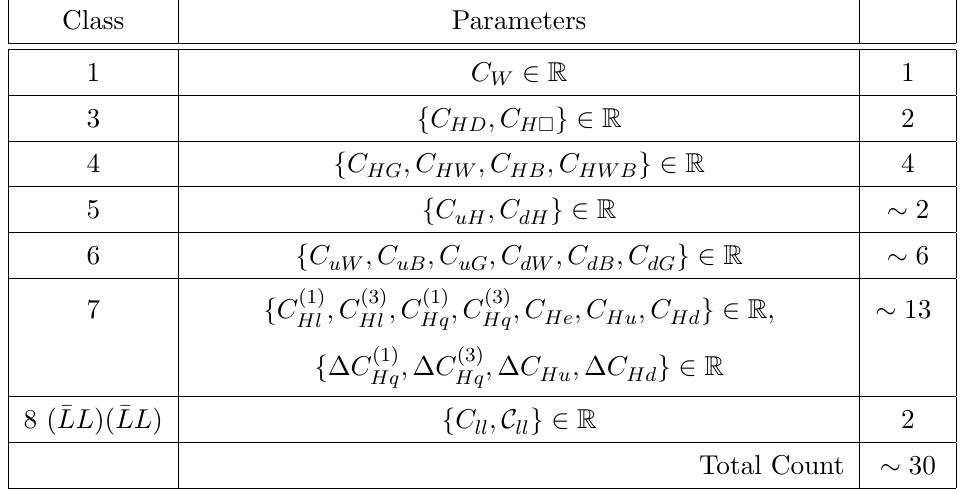
Table 7 . Parameter counts in the MFV SMEFT for a ‘WHZ pole parameter’ program. The parameter counts that are approximate rely on expanding numerically in the Yukawa